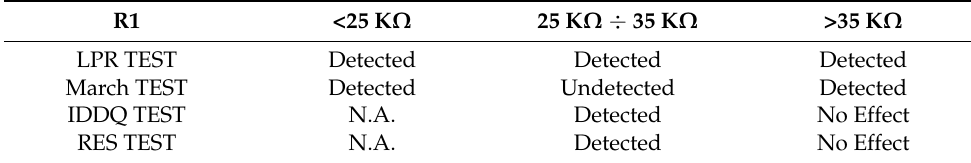
Table 5. Summary of the effectiveness of the different test methods with respect to